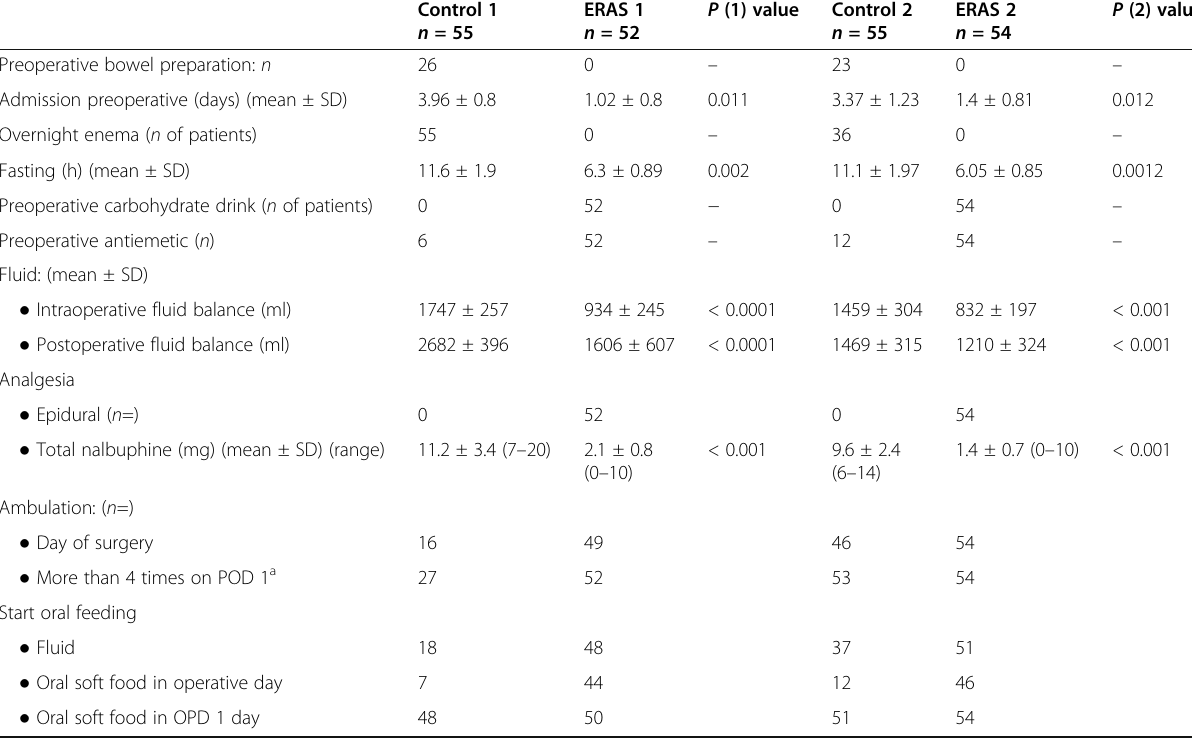
Table 1 Shows component of the protocol applied to different